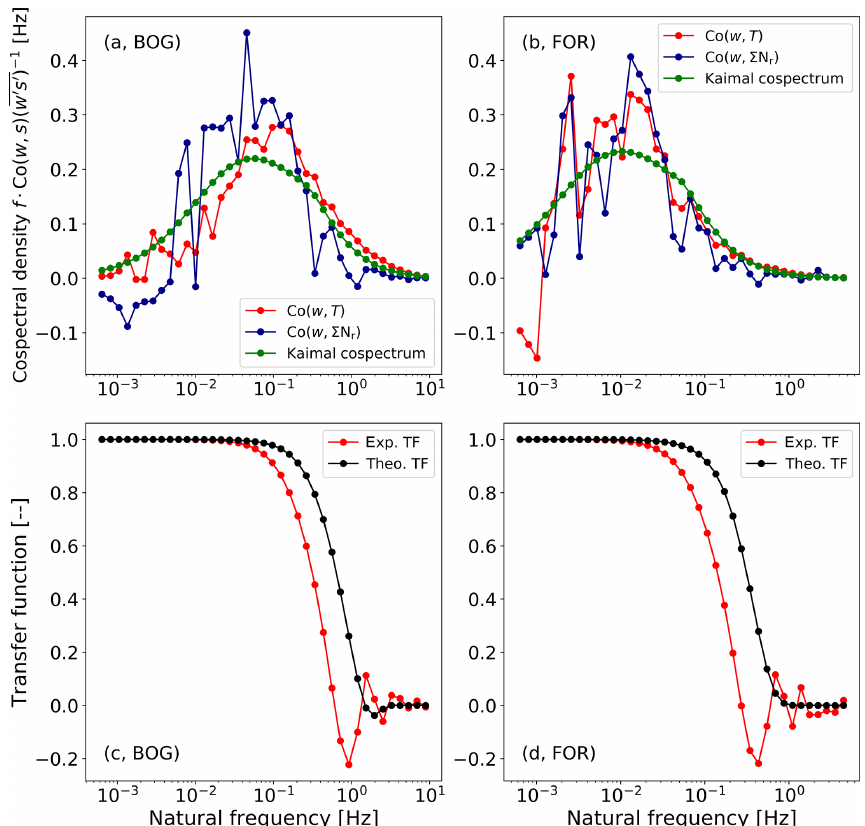
Figure 1. Comparison of observed normalized cospectra with modified Kaimal cospectra (green) for similar wind speed and stability and their theoretical and experimental transfer functions at BOG (a, c) ( ζ = − 0 . 23, u = 1 . 38ms − 1 ) and FOR (b, d) ( ζ = 0 . 17, u = 2 . 04ms − 1 ). Panels (c, d) show the theoretical cospectral transfer function (TF theo ) (black) and the experimental transfer function (TF exp ) (red). The experimental transfer functions were determined with the cospectra in (a, b) . The displayed cospectra of heat (red) and (cid:54) N r mass flux (blue) are averaged over half-hourly measurements on 10 October 2012 between 09:30 and 14:00CET and on 28 October 2016 between 10:00 and 15:30CET for BOG and FOR, respectively. The choice of different days was caused by data gaps in the